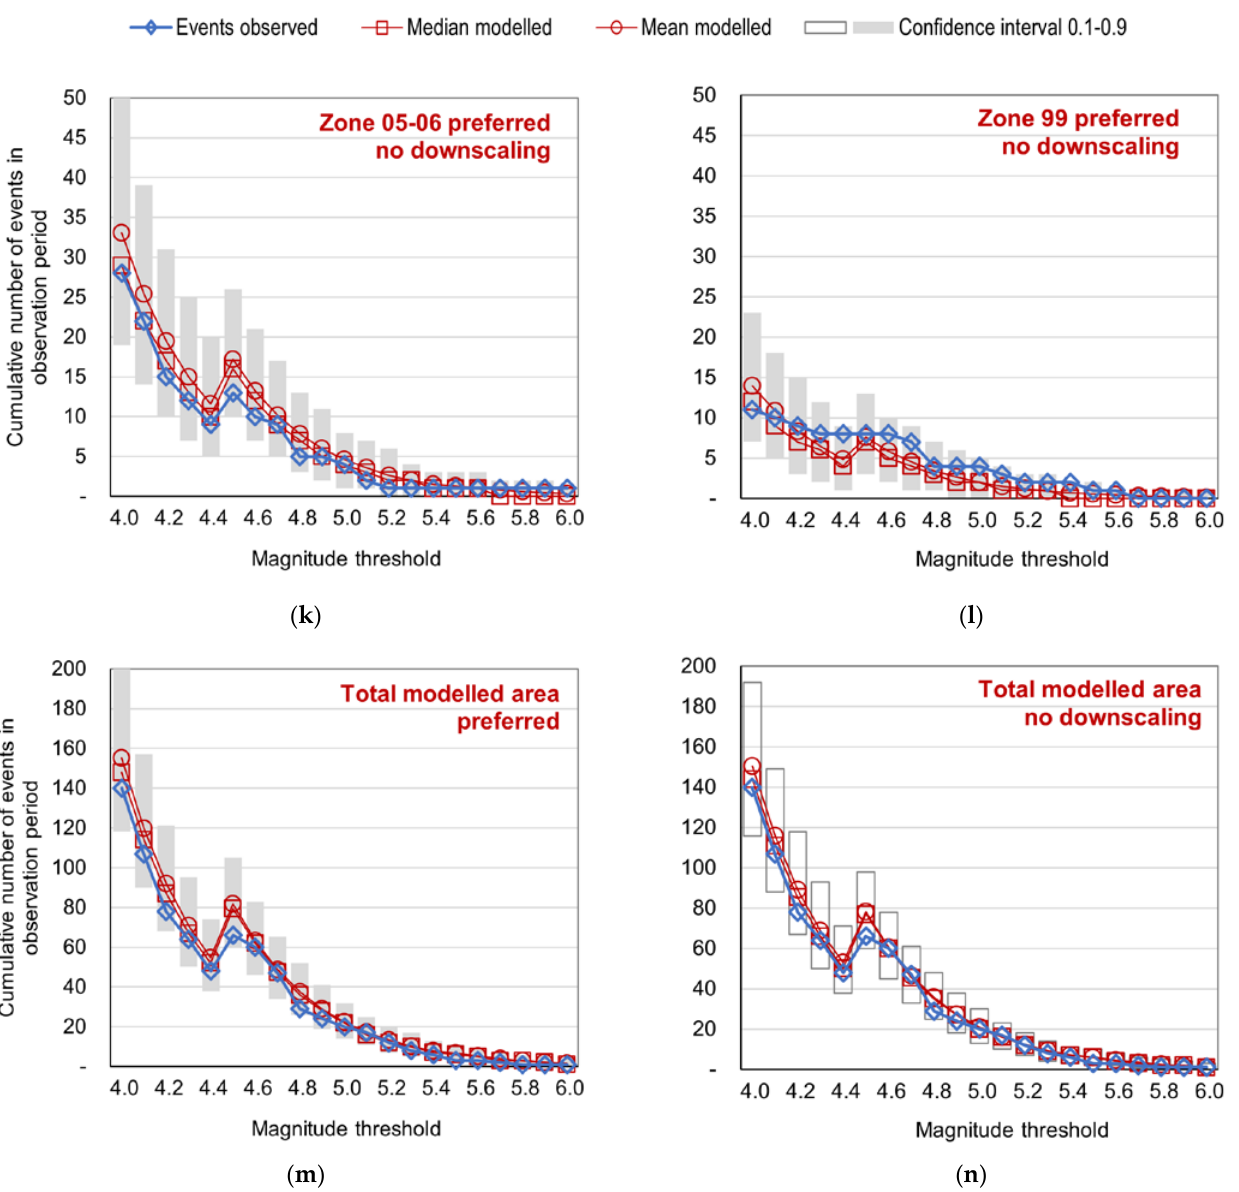
Figure 12. Comparison of long-term event counts by zone, modelled and observed. The modelled distributions were obtained by generating 500 stochastic catalogues using the downscaled parameters and another 500 stochastic catalogues with the original parameters, each one spanning 300 years. The observation periods reflecting completeness differ by magnitude class; therefore, the event numbers shown are not always decreasing with the magnitude threshold. ( a , c , e , g , i ) Zone-by-zone downscaled model results. ( b , d , f , h , j ) Results for the same zones with parameters before downscaling, for comparison. ( k , l ) Results for Zones 05–06 and 99 where the downscaling approach is not used. ( m , n ) Results for the total modelled area, with and without downscaling.